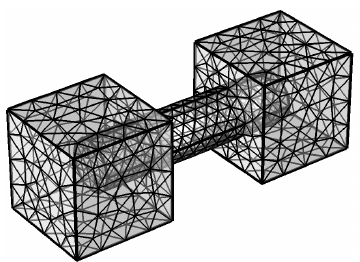
Fig. 6: Mesh representation of example geometric model. Fine mesh.